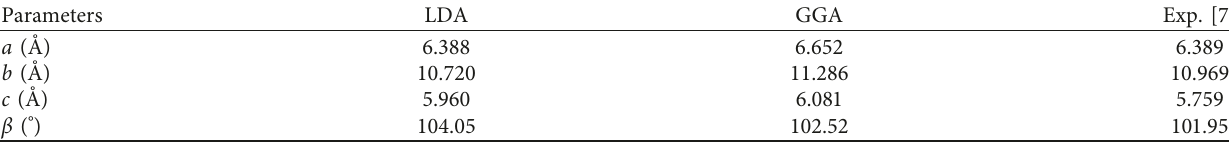
Table 1: Lattice parameters of qatranaite estimated with the LDA and GGA and compared with the measured values. Parameters